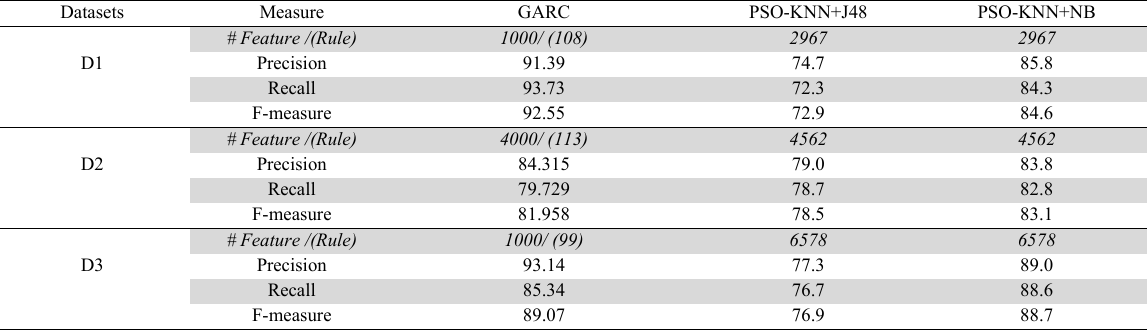
Comparison of results of the GARC and results of other